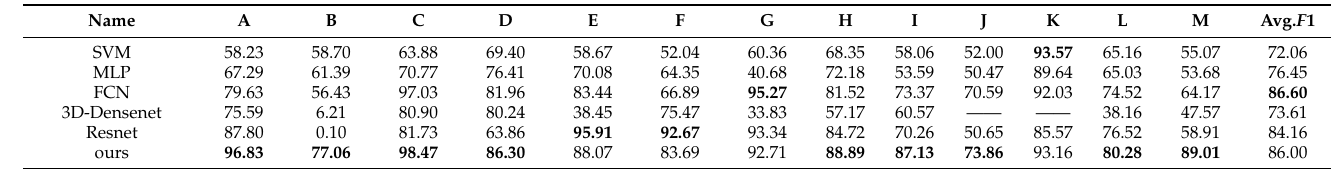
Table 6. Per category results for Area_2. The best results are highlighted in